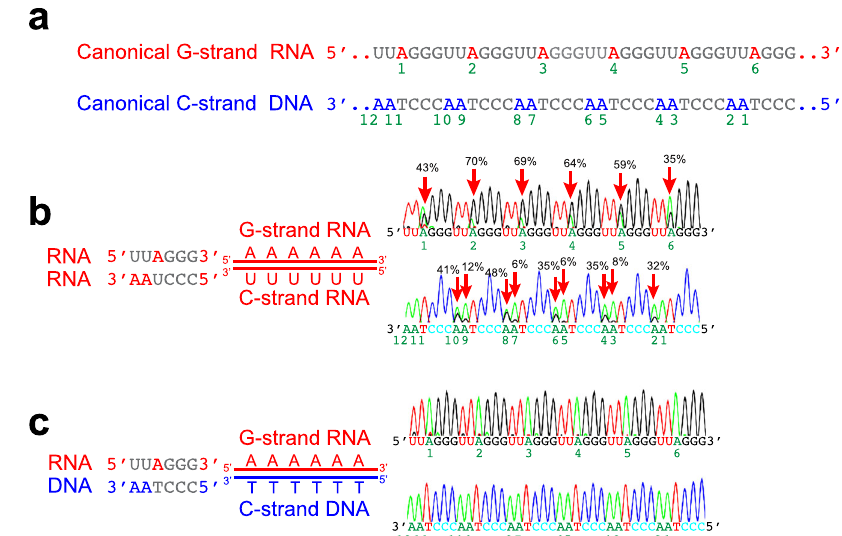
Fig. 4 ADAR1p110 cannot edit completely matched RNA:DNA hybrids carrying telomeric repeat sequences. a Canonical telomeric repeat sequences of G-strand RNA (red) and C-strand DNA (blue) are shown. Six adenosines of the G-strand RNA and twelve adenosines of the C-strand DNA are indicated by numbers 1 – 6 and 1 – 12, respectively. b In vitro editing assay for completely matched telomeric repeat dsRNA was conducted using ADAR1p110-WT recombinant protein. c In vitro editing assay for completely matched telomeric repeat RNA:DNA hybrids using ADAR1p110-WT recombinant protein. No signi fi cant levels of editing for matched RNA:DNA hybrids were detected. b , c PCR products (RT-PCR-ampli fi ed RNA strands and PCR-ampli fi ed DNA strands) were subjected to Sanger sequencing. The editing frequency was estimated as the % ratio of the guanosine (black) peak over the sum of guanosine and adenosine (green) peaks of the sequencing chromatograms. Editing frequency estimated for three independent experiments ( n = 3, technical replicates) is presented in Supplemental information (Supplementary Data 2 and Source Data fi